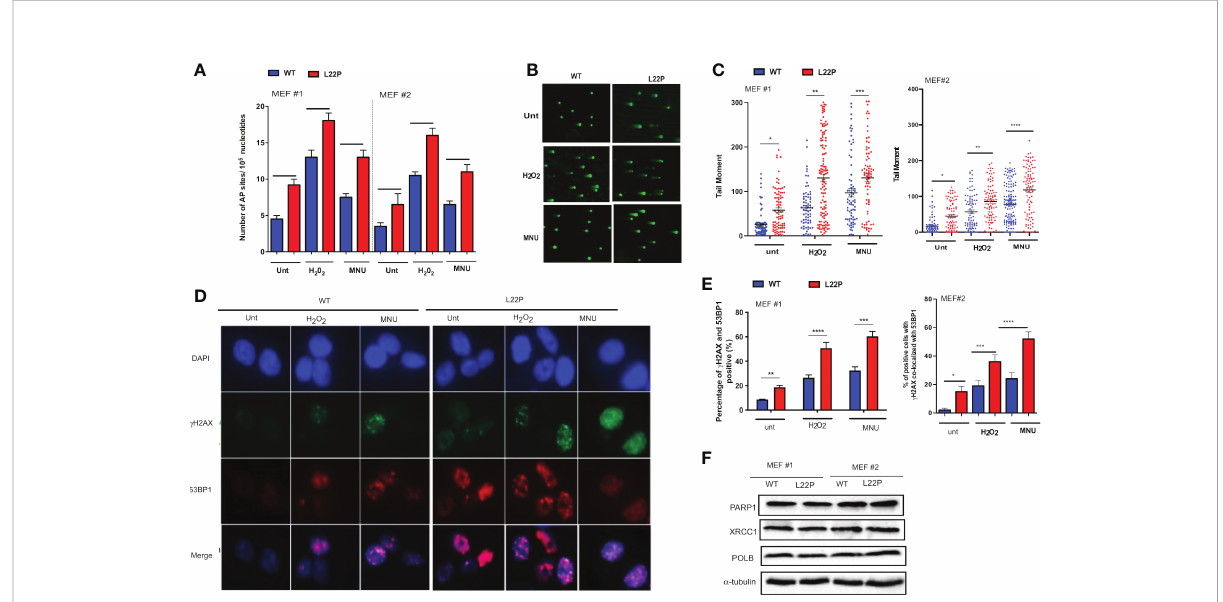
FIGURE 1 Loss of dRP lyase function causes mitotic dysfunction and telomere crisis. (A) Estimated AP sites with and without MNU and/or H 2 O 2 treatment in WT and L22P cells; The number of AP sites was measured and calculated based upon a standard curve generated using ARP standard DNA solutions as described previously (DNA Damage AP sites assay kit, Colorimetric, Abcam). (B) Representative image of single stranded breaks (SSBs) from Comet assay with and without alkylating agent (MNU) and hydrogen peroxide (H 2 O 2 ) induced in dRP lyase de fi cient (L22P) versus pro fi cient (WT) cells; (C) Percentage of cells with SSBs in WT versus L22P cells from Comet assay. The data were analyzed based on the paired t-test using GraphPad Prism software. (n=3 independent experiments with at least 100 comets from each groups included for analysis); (D) Representative image of co-localization of gH2AX (green) and 53BP1 (red), which represents DSBs; (E) Percentage of cells positive for co- localization of H2AX/53BP1 proteins shows DSBs in WT and L22P cells. All images were taken 63x Zeiss microscope from three independent experiments and any cells with >5 foci of g H2AX/53BP1 co-localization per cell were categorized as positive. (F) Western bot analysis of BER proteins (PARP1, XRCC1 and POLB) from MEF#1 and MEF#2 cells. Two MEF cell lines (labeled as MEF #1 and MEF #2) were used to generate the data. Two-way ANOVA followed test or student ’ s test were performed to analayze the data from three independent experiments. P*<0.05, **P<0.01, ***P<0.001,